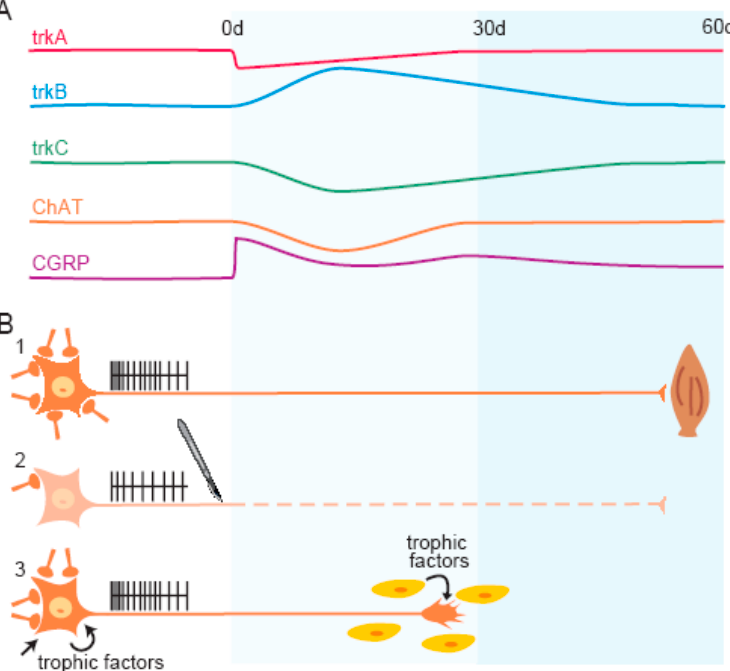
Figure 3. Cartoon indicating alterations in extraocular motoneurons after axotomy: ( A ) time course of changes in the expression of Trk receptor mRNA, ChAT and CGRP (calcitonin gene-related peptide) in extraocular motoneurons after axotomy; d, days; ( B - 1 ) the connected neuron shows a normal phenotype in afferent synaptic activity and firing rate; ( B - 2 ) the axotomized neuron has reduced levels of firing rate and afferent synaptic activity; and ( B - 3 ) the neuron switches from a transmitter to a regenerative phenotype where the autocrine/paracrine and anterograde trophic support gain relative importance with respect to the retrograde trophic support. Appropriate levels of retrograde trophic factors delivered from different sources would restore the values of altered molecules. Modified from [85].